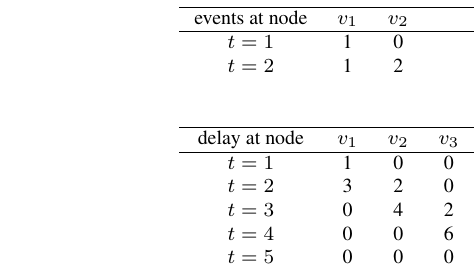
Fig. 1: Example execution of KNR where the transmission cost c is